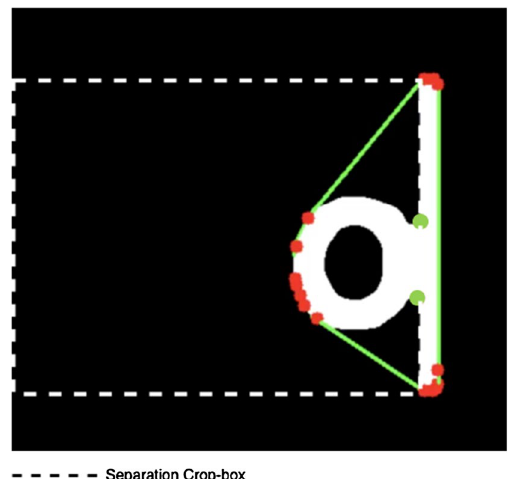
Fig. 7 Separation Crop-box for Sticking Characters Separation, areas inside the dotted line contains the character without the Text